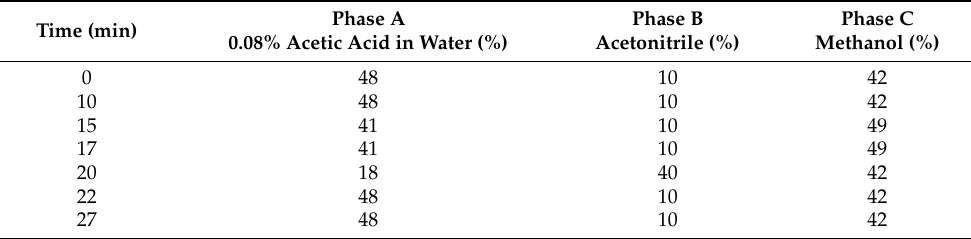
Table 4. Gradient elution of sulfonamides with HPLC-FLD detection